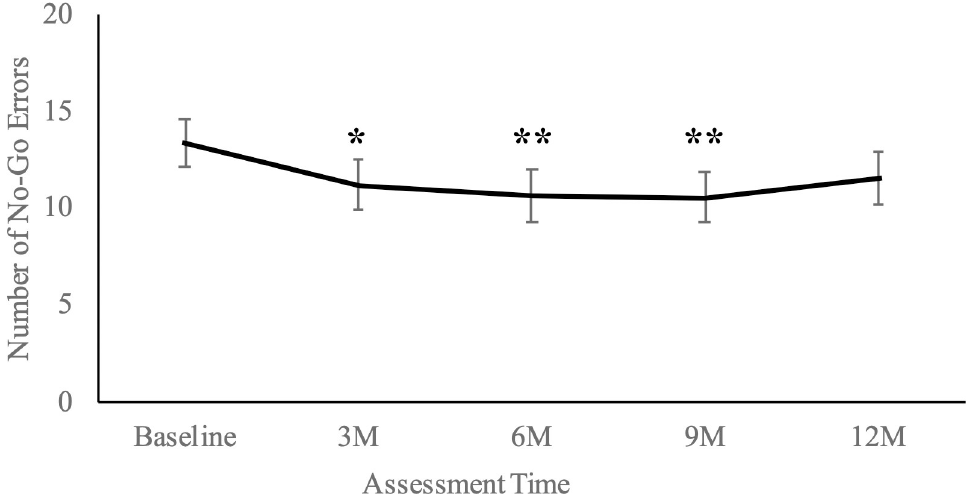
Fig 3. Model-estimated averages (mean ± SE) of total No-Go errors on the Go No-Go task at each assessment point. Legend: M = Month. ��� indicates p < .001, �� indicates p < .01, and � indicates p < .05, compared to baseline.